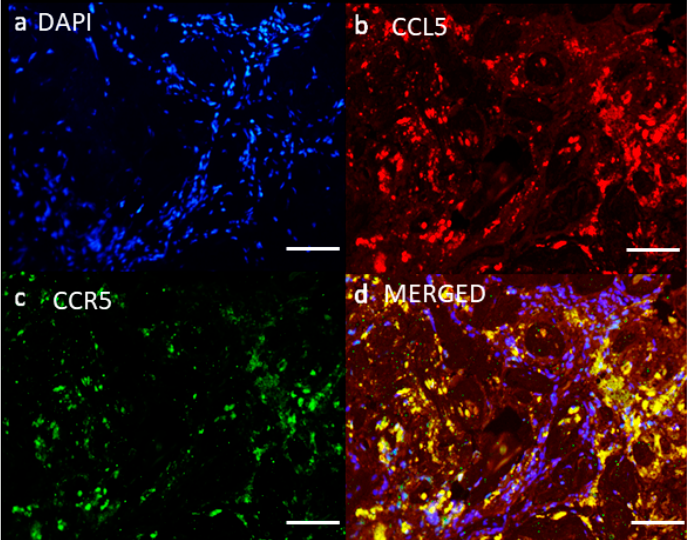
Figure 1. CCL5 and CCR5 are expressed in glioblastoma tissue. Fluorescence immunohistochemical staining of CCL5 and CCR5 antigen was performed on the glioblastoma section. ( a ) Nuclei were stained with DAPI (blue), ( b ) CCL5 with Alexa Fluor 546 (red), and ( c ) CCR5 with Alexa Fluor 488 (green) dye. ( d ) Merged images represent colocalization (yellow color) of CCL5 and CCR5. Microscopy was carried out at 20 × objective magnification. Scale bar represents 100 µ